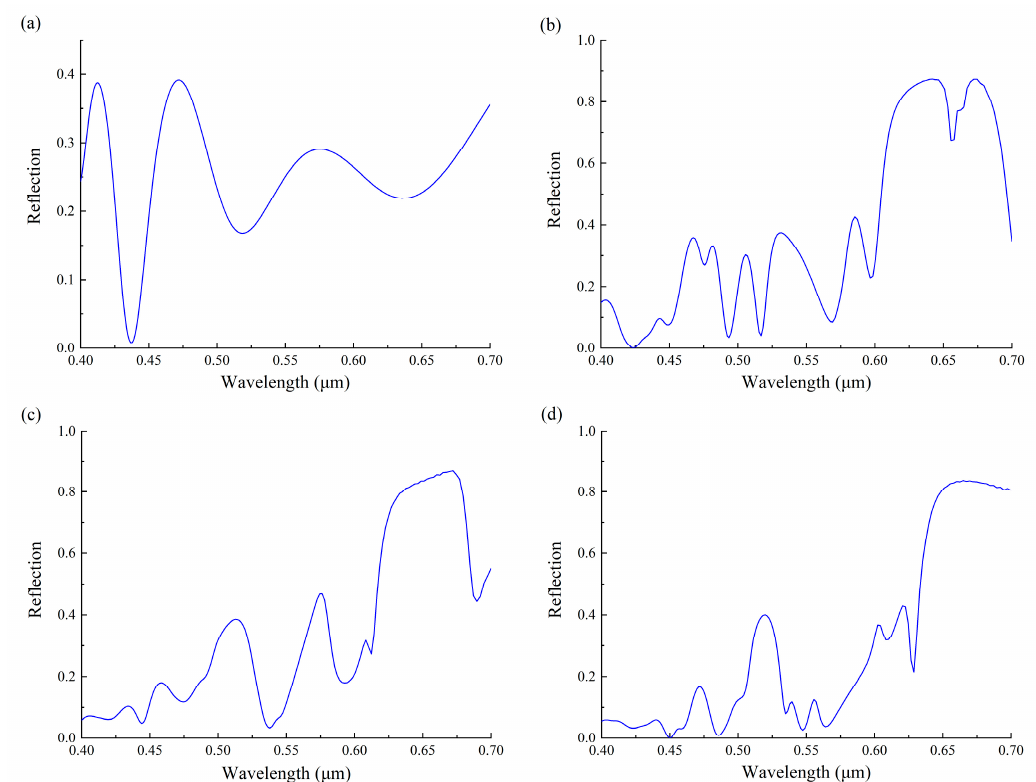
Figure 3. The reflection spectra of different D . ( a ) The reflection spectra with D = 30 nm when p is invariable. ( b ) The reflection spectra with D = 200 nm when p is invariable. ( c ) The reflection spectra with D = 180 nm when p is variable. ( d ) The reflection spectra with D = 200 nm when p is variable.